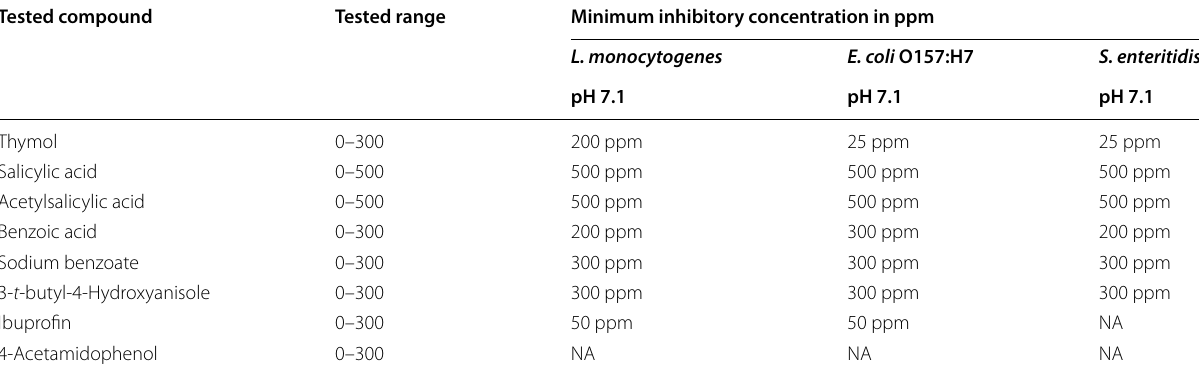
Table 2 Minimum inhibitory concentration of the natural and organic antimicrobials against L. monocytogenes, E. coli O157:H7, and S. enteritidis at pH